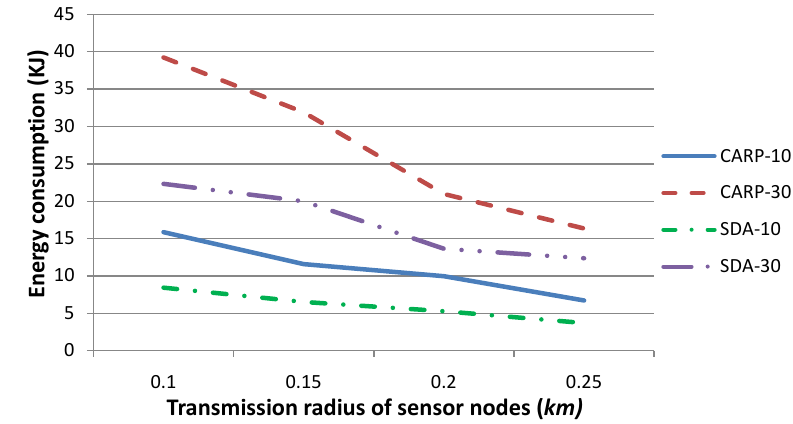
Figure 12. Comparison of energy consumption for our technique (SDA) with respect to CARP as the routing protocol, when the number of time slots is set to 10 and 30, respectively. This figure shows that the energy consumption for our technique is less than that of CARP, especially when the communication radius r is set to a relatively small value.